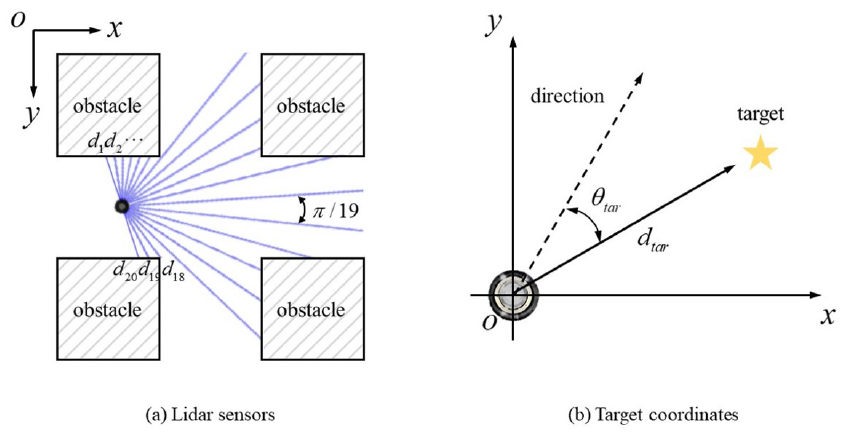
Figure 1. Range sensory data and target